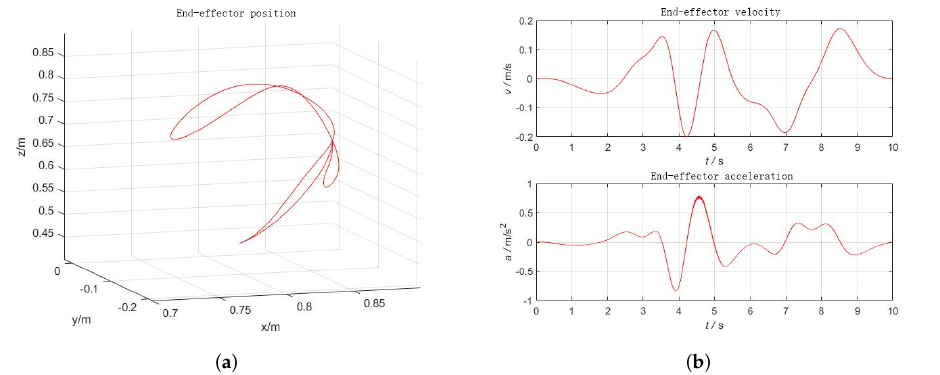
Figure 2. Joint-time trajectory.